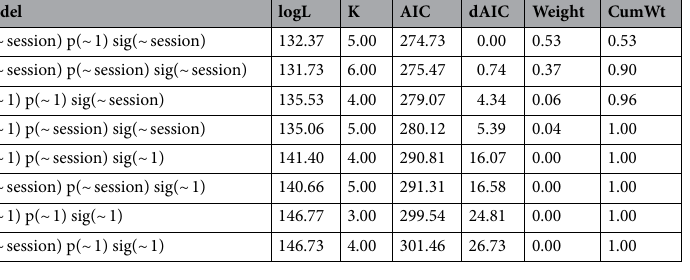
Table 2. Comparison of spatially explicit capture-recapture (SCR) models tested on camera trap data of snow leopards to evaluate the effect of sampling design. D density, p detection probability, sig sigma ( σ) , asu cost